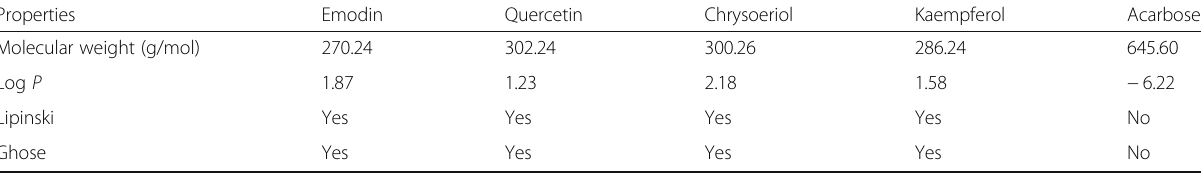
Table 3 Drug-like natures of emodin, quercetin, chrysoeriol, kaempferol, and acarbose